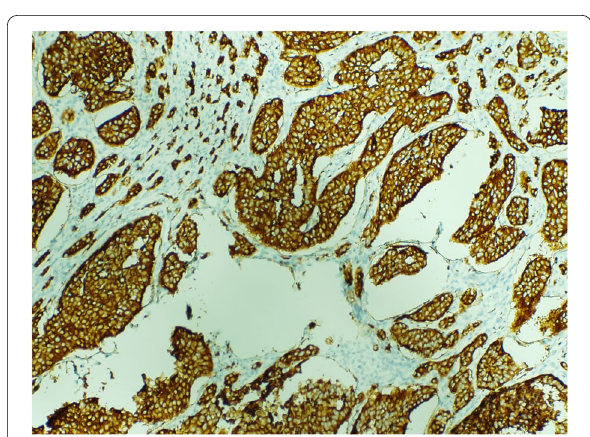
Fig. 3 Synaptophysin stain (magnification: strongly positive with synaptophysin antibody diffusely